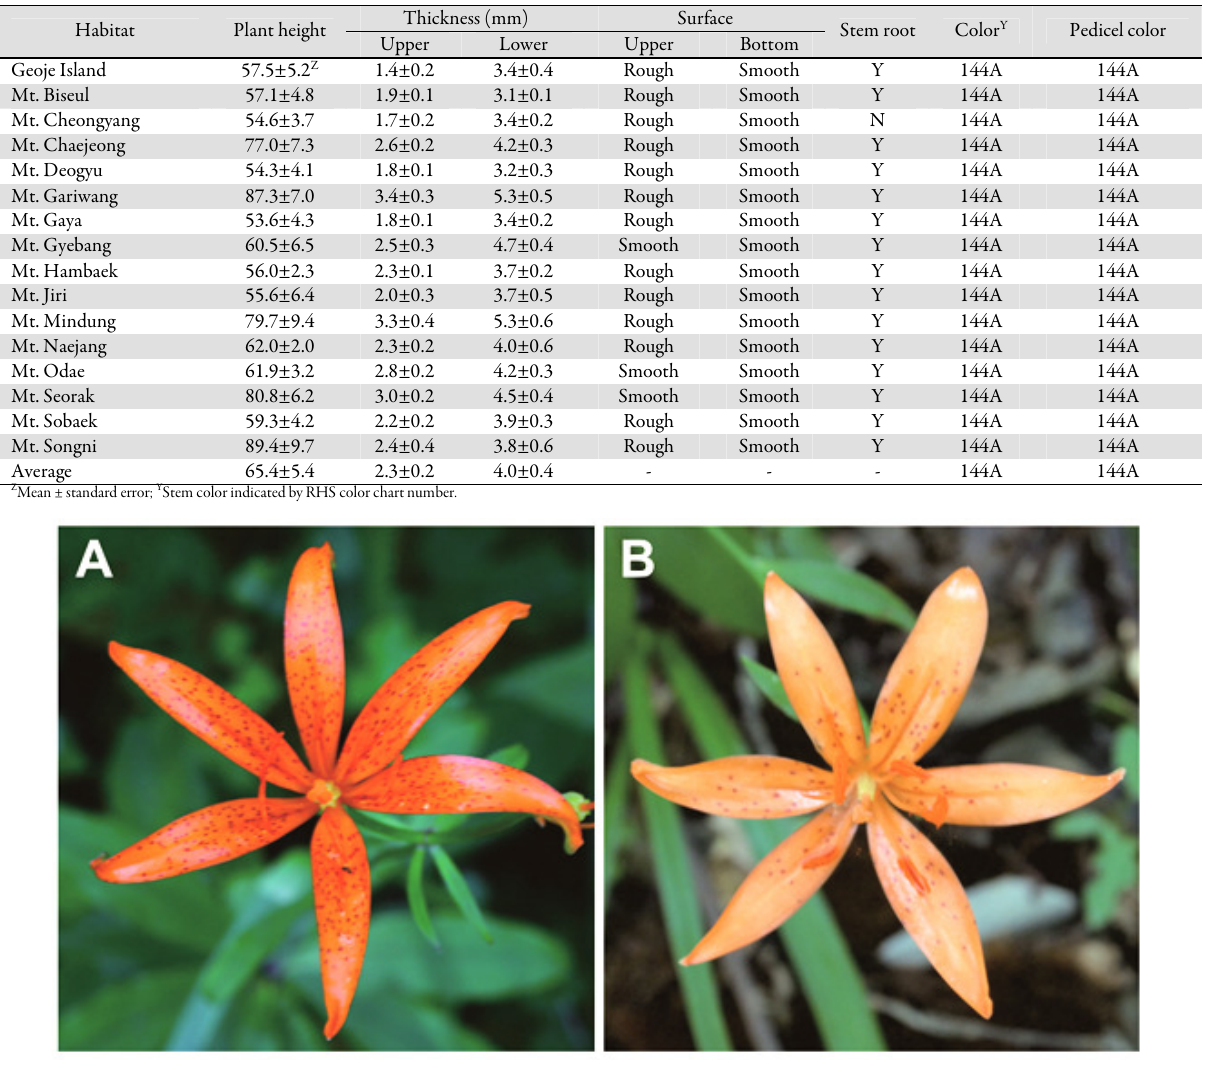
Fig. 2. Variation of flower color and spots in L. tsingtauense : A) orange color with many spots; B) few spots with light orange flower (mutant